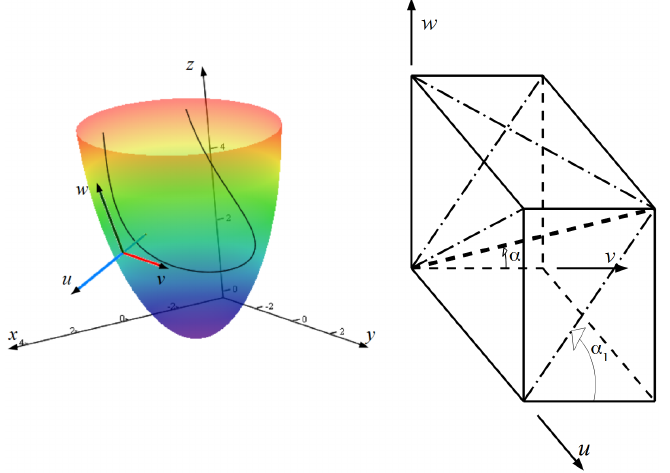
Figure 6. The definition of the local coordinate system is shown on the ( left ) of the image. Oxyz is the global Cartesian coordinate system. The blue axis is normal, u , to the epicardium. The red axis is parallel tangent, v . The dark green axis is a meridian tangent, w . The colorful surface is the epicardium; the color depends on altitude z . The curve inside is a model fiber, and it does not lie on the epicardium. The normal axis intersects the curve at a point. On the ( right ), the definitions of the true fiber angle α and the helix angle α 1 are shown. The thick, dashed line is a tangent to a myofiber segment constructed at the origin of the coordinates. The dashed-and-dotted lines are projections of the myofiber tangent. (Copied from [53] (Figure 9) with a deletion of angle α 2